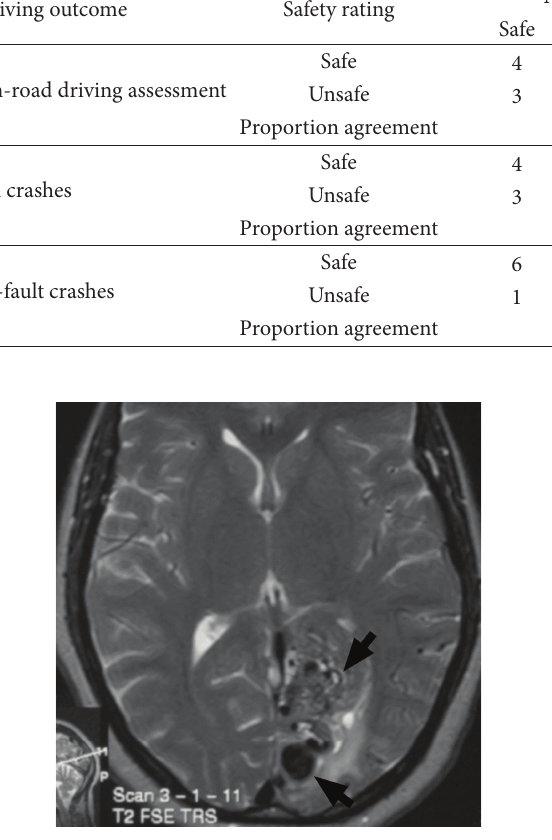
Figure 2: Axial T1 MRI shows evidence of a small left parietooccip- ital infarction yet the patient was determined to be an unsafe